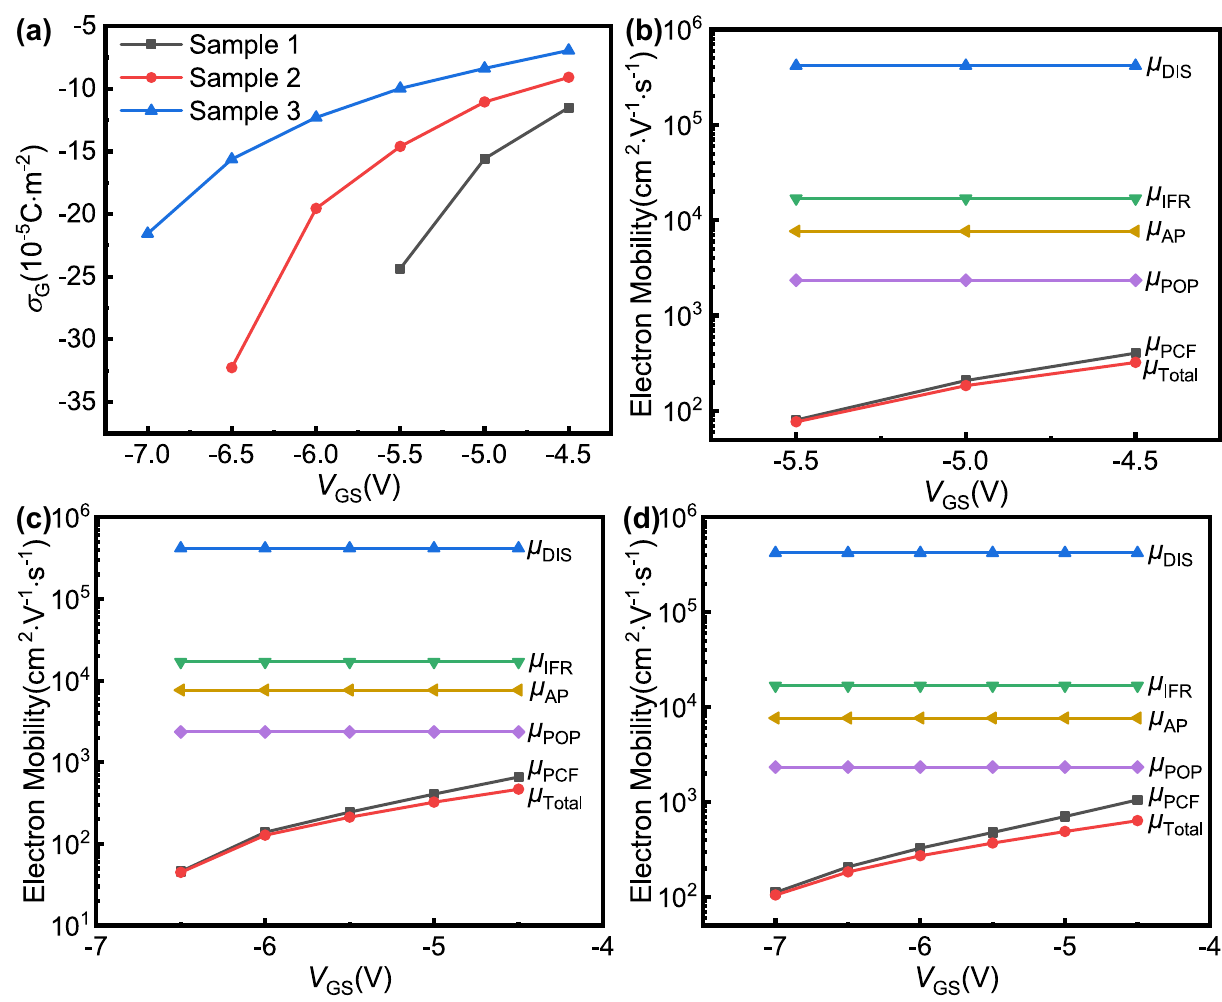
Figure 6. The calculated ( a ) additional polarization charge density for open-gate samples and various electron mobilities for ( b ) sample 2, ( c ) sample 3, and ( d ) sample 4 as a function of the gate bias. μ DIS , μ IFR , μ AP , μ POP , μ PCF and μ Total correspond to the electron mobility of DIS scattering, IFR scattering, AP scattering, POP scattering, PCF scattering, and total electron mobility,